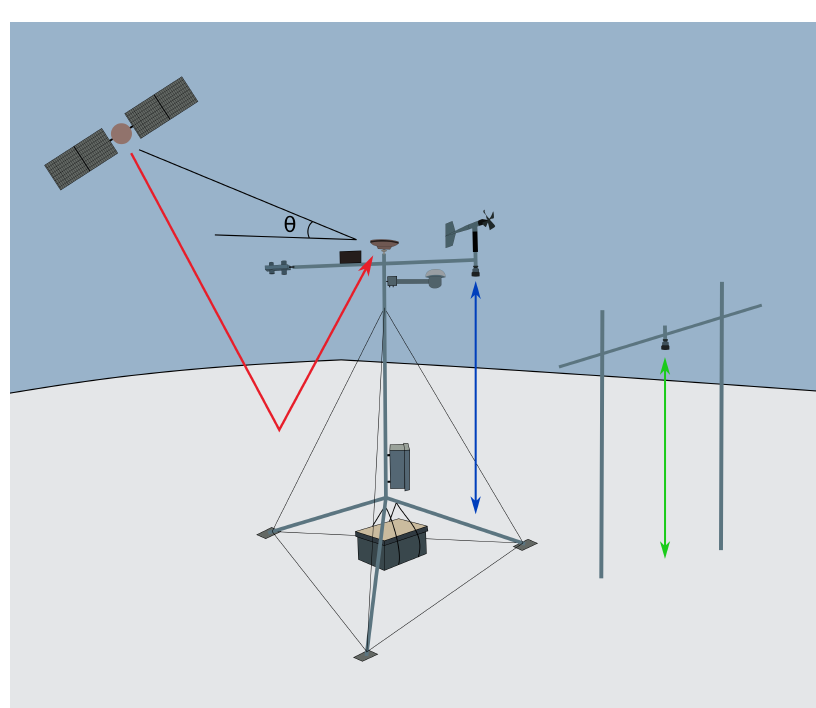
Figure 2. Illustration of PROMICE weather station NUK-K. The red arrow illustrates reflected signal used for Global Navigation Satellite System Interferometric Reflectometry (GNSS-IR) reflector heights. The blue arrow illustrates reflector height measured by the sonic ranger on the boom. The green arrow illustrates the distance to the snow surface as measured by the sonic ranger on